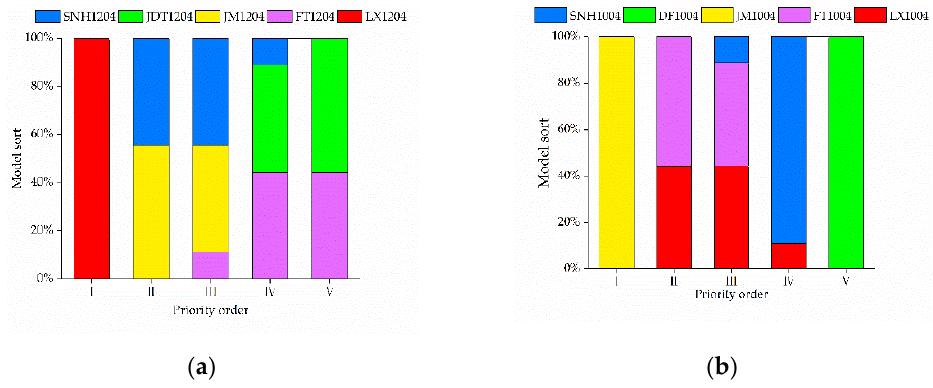
Figure 6. ( a ) Proportion of the priority order of machinery type in 88.2 kW; ( b ) proportion of the priority order of machinery type in 73.5 kW. priority order of machinery type in 73.5